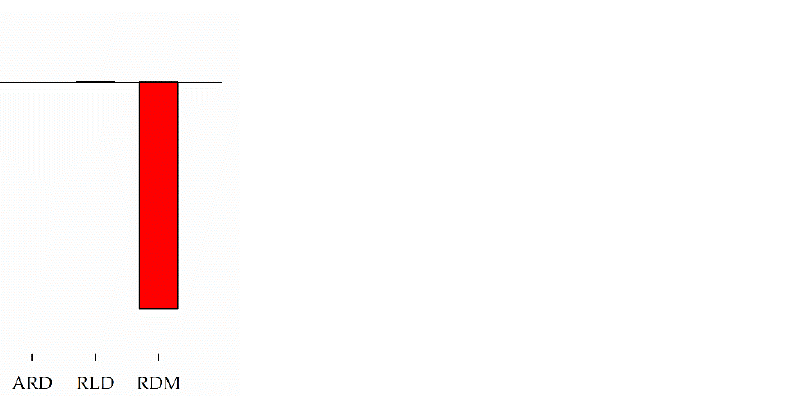
Figure 4. Dispersion of observations in principal component 1 of yield components ( A ), Physiological traits ( B ), Root development ( C ), Soil physics ( D ), and Water soil ( E ) variables. The lower soybean yield, observed in CT (4.200 kg ha − 1 ), was associated with smaller plants, but with a greater number of pods, lower water content and water potential in the leaf, greater root dry matter and soil penetration resistance, and lower infiltration and basic rate of water infiltration into the soil (Figure 4).